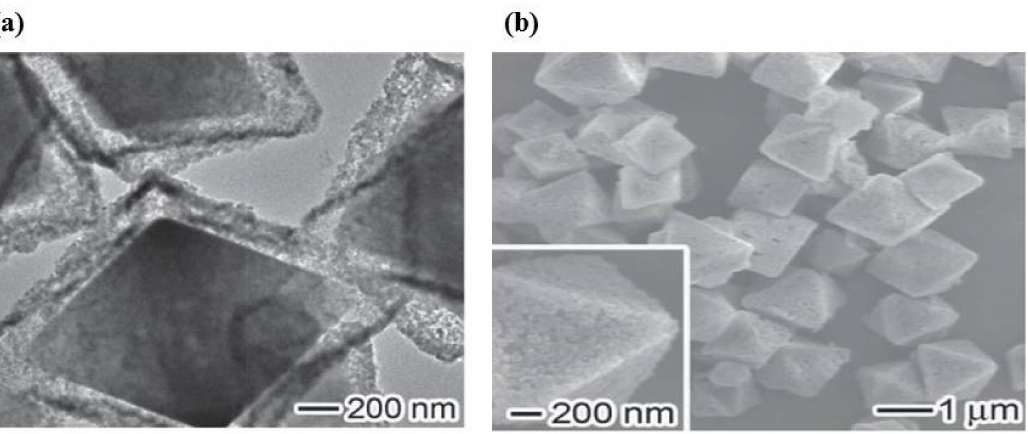
Figure 21. ( a ) TEM and ( b ) SEM images of the synthesized Cu 3 (BTC) 2 @TiO 2 core-shell struc- tures